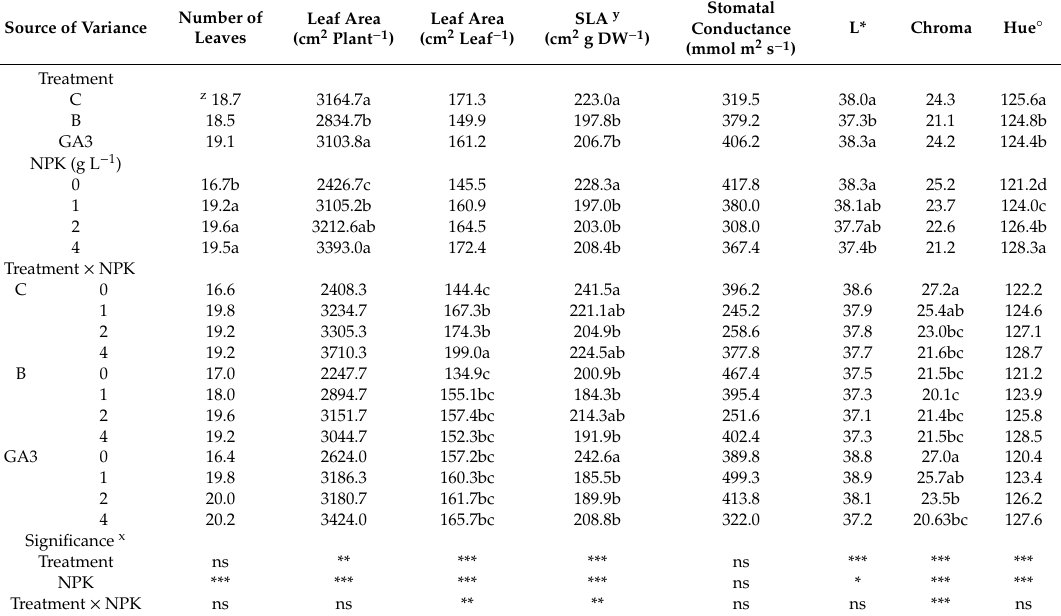
Table 5. E ff ects of the seedling treatments (C, untreated control, B, bacterial biostimulant, GA3, characteristics of Solanum lycopersicum ‘Marmande’ plants grown in soilless